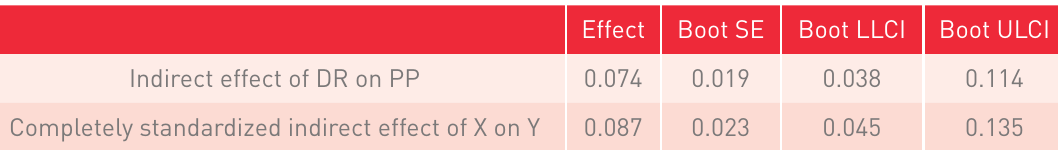
Bootstrap results